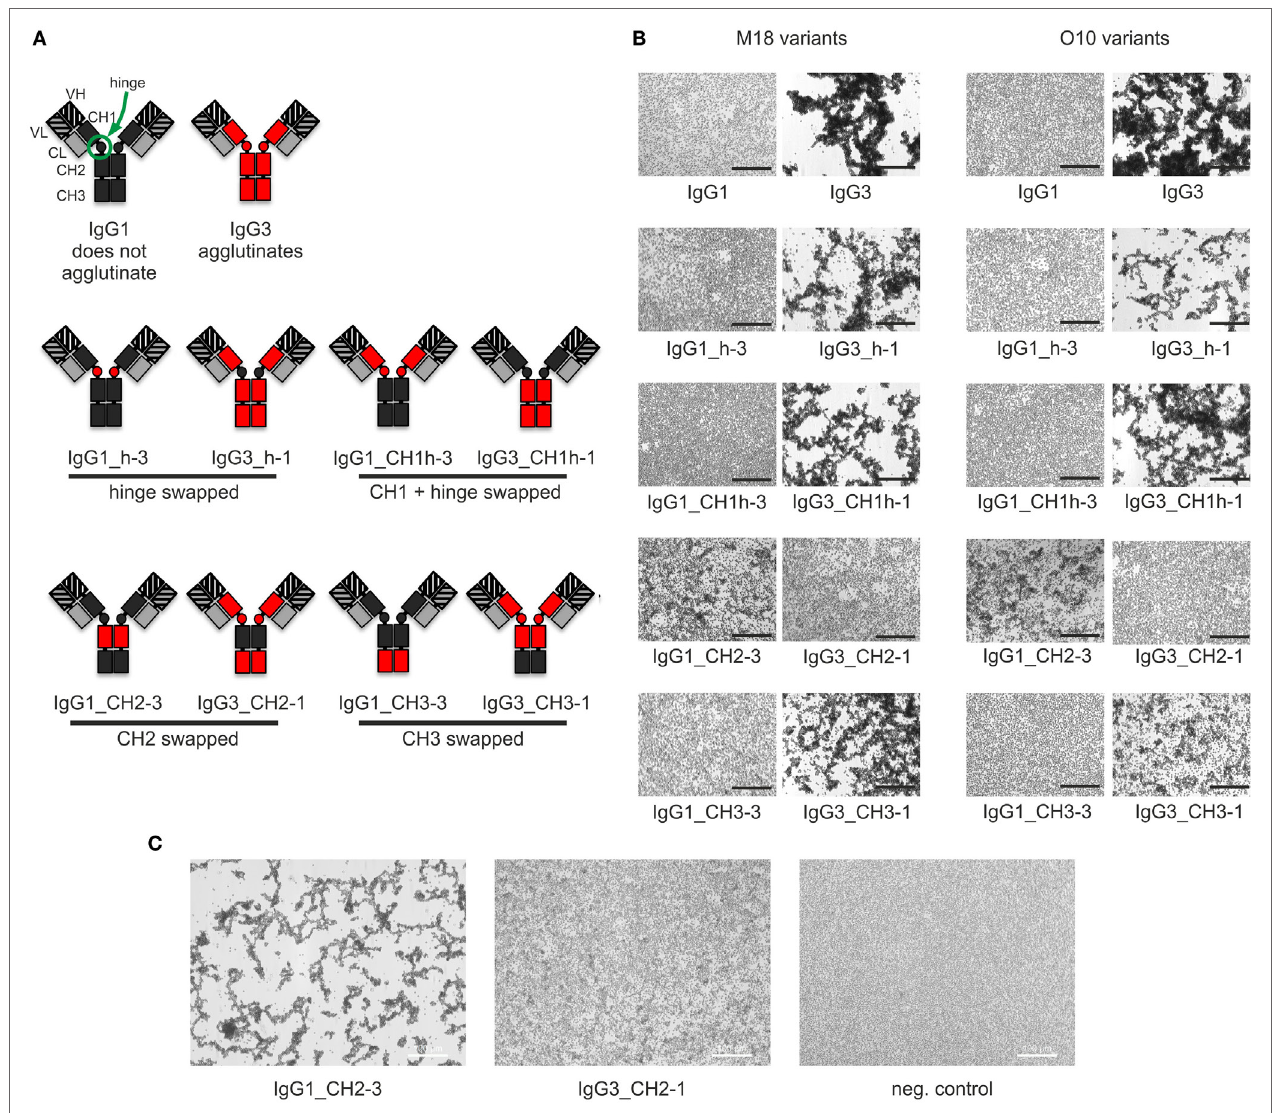
FigUre 2 | Hemagglutination induced by IgG1 and IgG3 muteins. (a) Generated domain muteins and their nomenclature. (B) Microscopic images of hemagglutination induced by the domain muteins. All antibodies were used at a concentration of 1.5 µg/ml, except of O10 IgG1_CH2-3 that was used at 3 µg/ml. Scale bar—100 µm; (c) Hemagglutination induced by selected O10 muteins used at 10